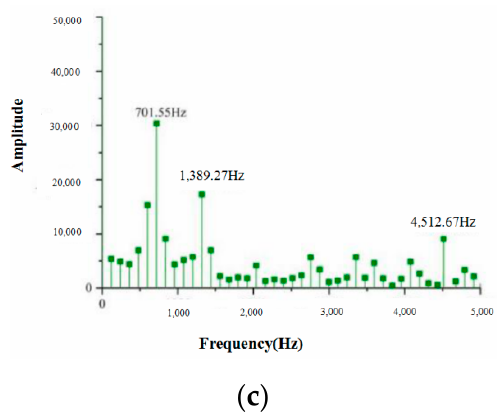
Figure 18. Frequency domain characteristic curve of S1 under different stall flow conditions: ( a ) the flowrate is 1.0 kg/s, ( b ) the flowrate is 0.8 kg/s, ( c ) the flowrate is 0.7 kg/s.